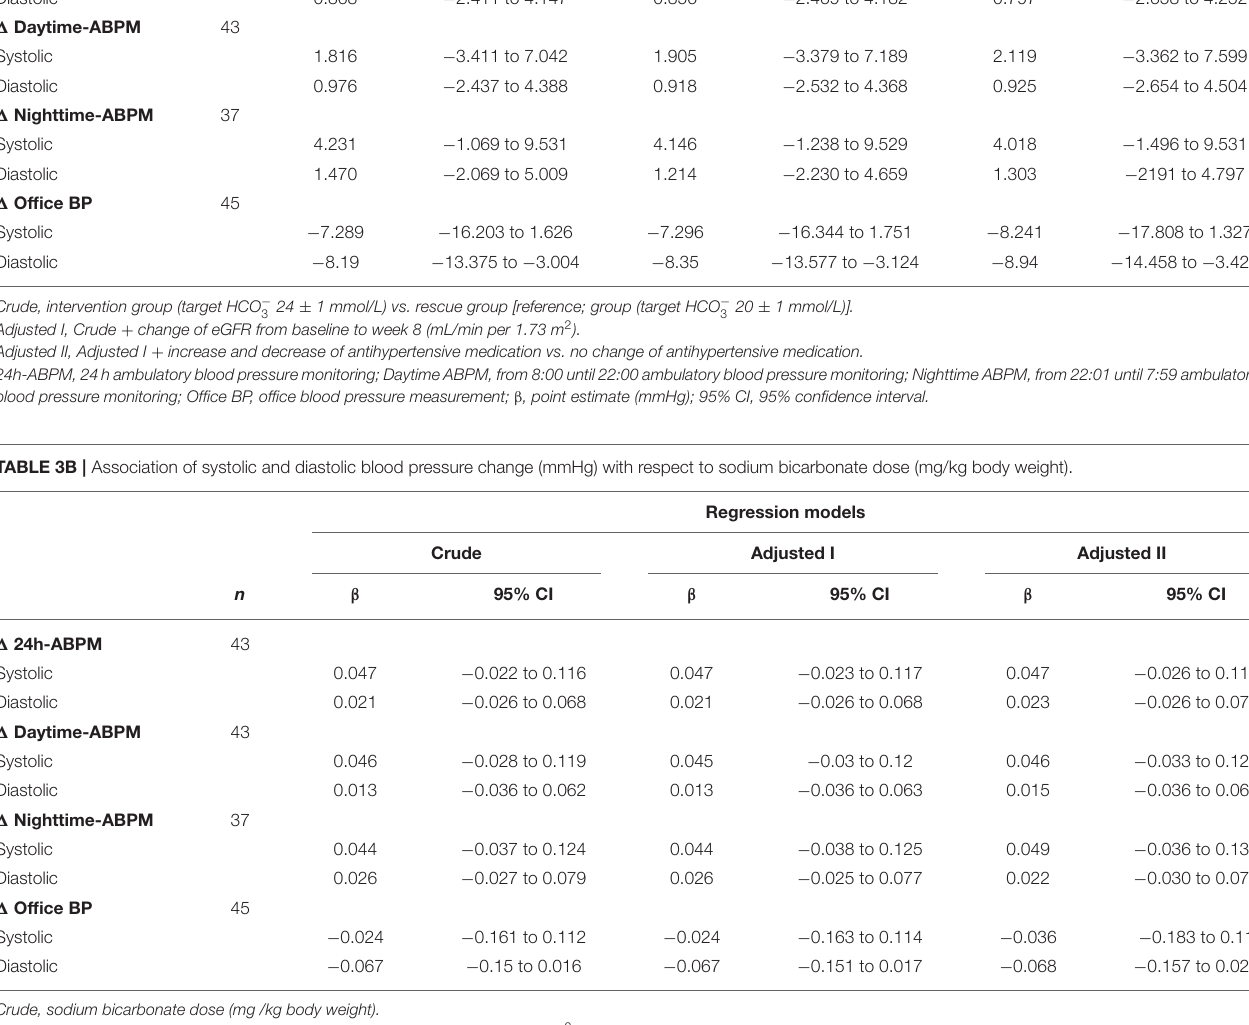
Regression models